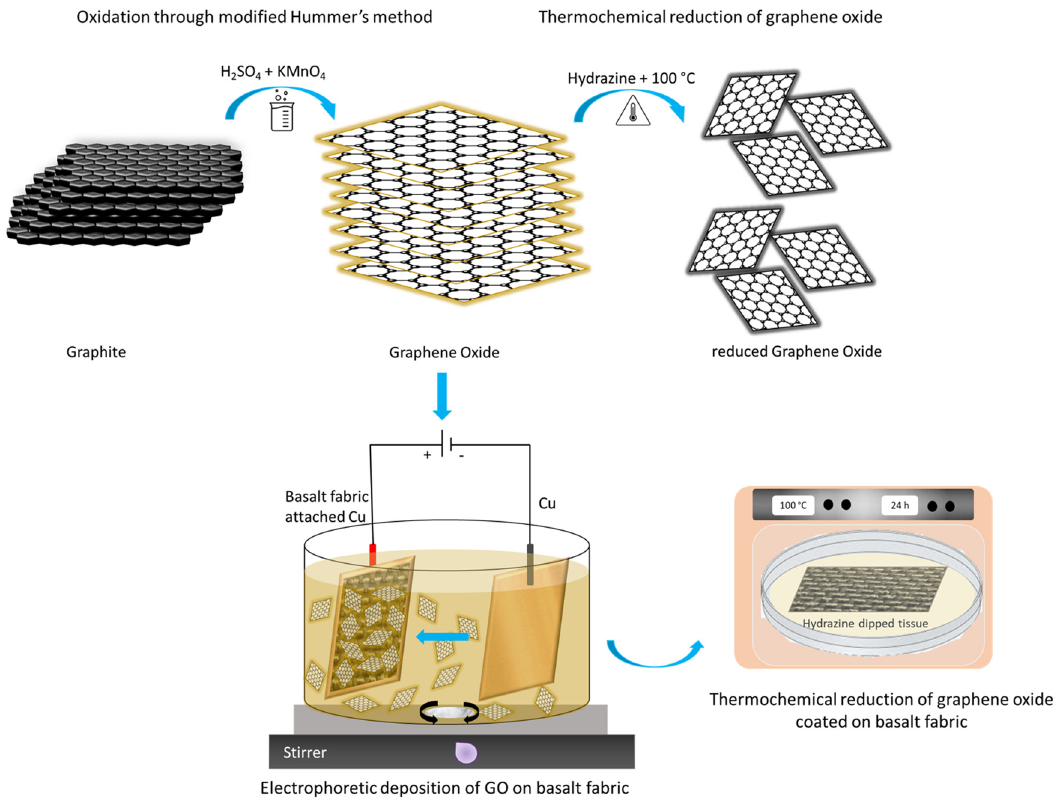
Figure 1: Schematic representation of deposition of graphene on basalt fabric through the EPD